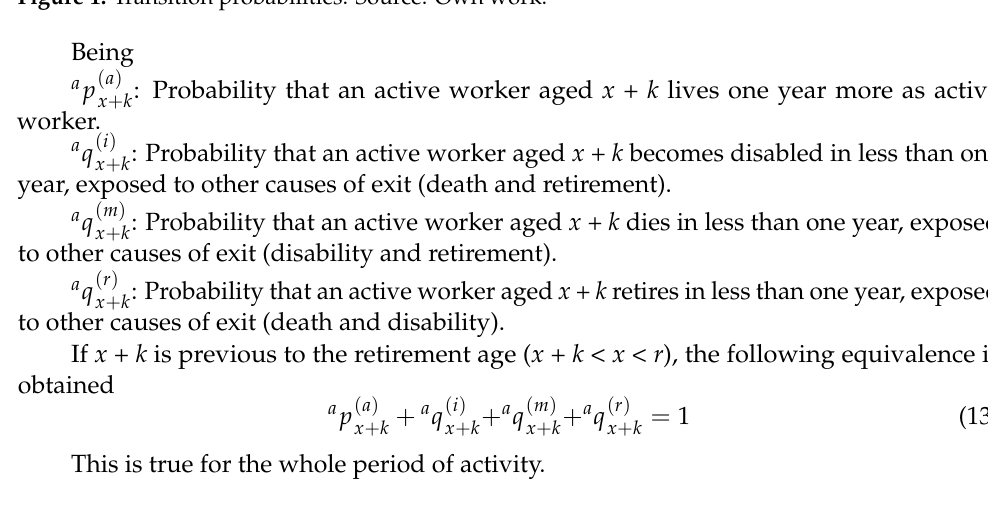
Figure 1. Transition probabilities. Source: Own work.